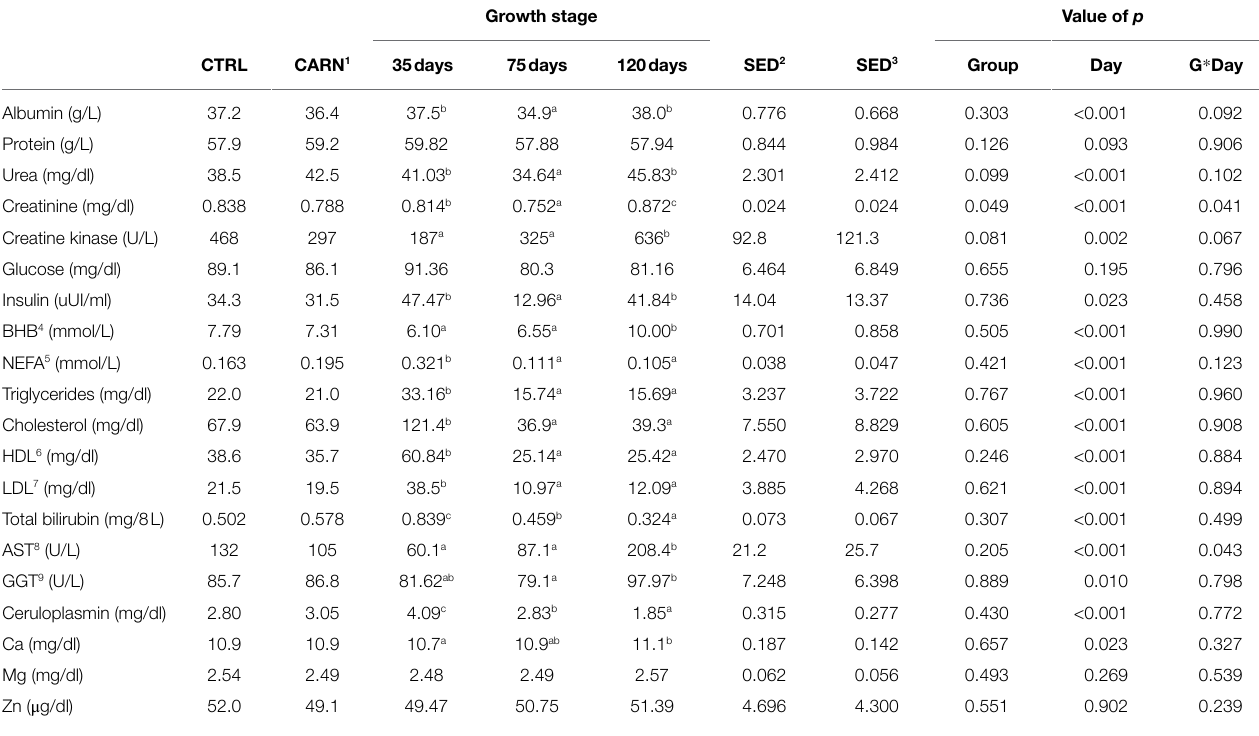
TABLE 2 | Biochemical parameters of early feed restricted lambs being fed the control (CTRL) or the L-Carnitine diet (CARN) during the fattening period. Growth stage CTRL CARN 1